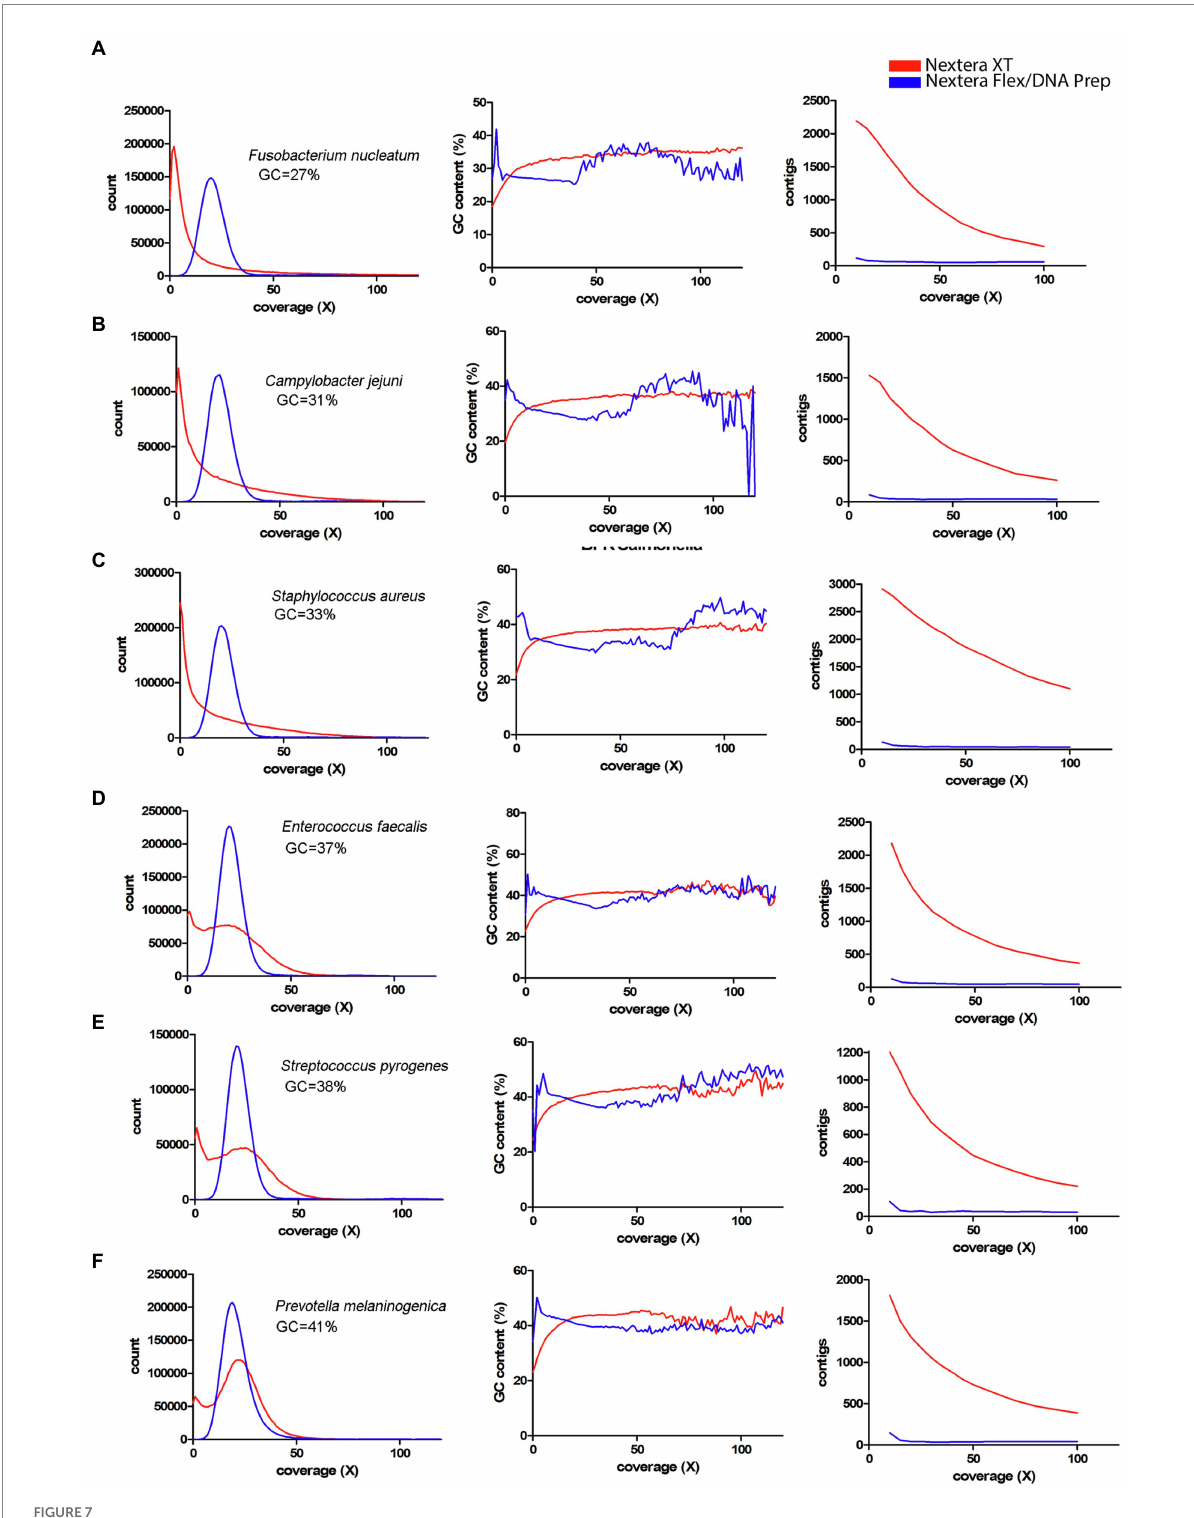
FIGURE 7 Coverage bias, connection to GC-content, and consequences on assembly efficiency for data produced with Nextera XT and Nextera Flex/DNA Prep in external datasets. The data have been colored to indicate the type of library prep kit used (Nextera XT red, Nextera Flex/DNA Prep blue). Left column represents histograms over the depth in the raw data (downsampled to 50x) of the k -mers present in the reference sequence. Middle column represents the corresponding average GC-content of the k -mers in each histogram bin. The right column represents the number of contigs generated by SPAdes assembler after filtering short and low coverage contigs. (A–F) Data from Seth-Smith et al. (2019) representing bacterial species with low